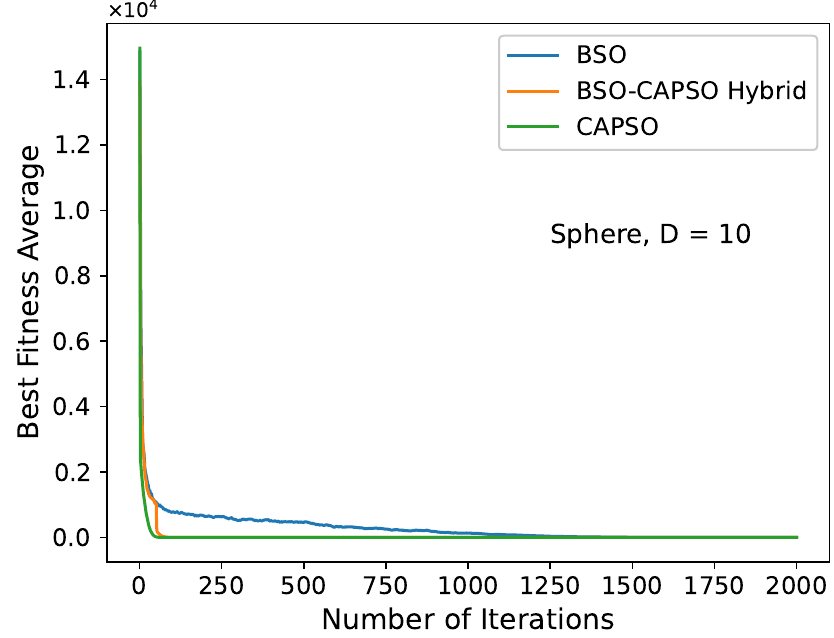
Figure 2. Convergence diagram of the stand-alone BSO, BSO–CAPSO hybrid and stand-alone CAPSO algorithms for the sphere ( f 1 ) function with D = 10. Convergence acceleration occurred after t switch = 50.